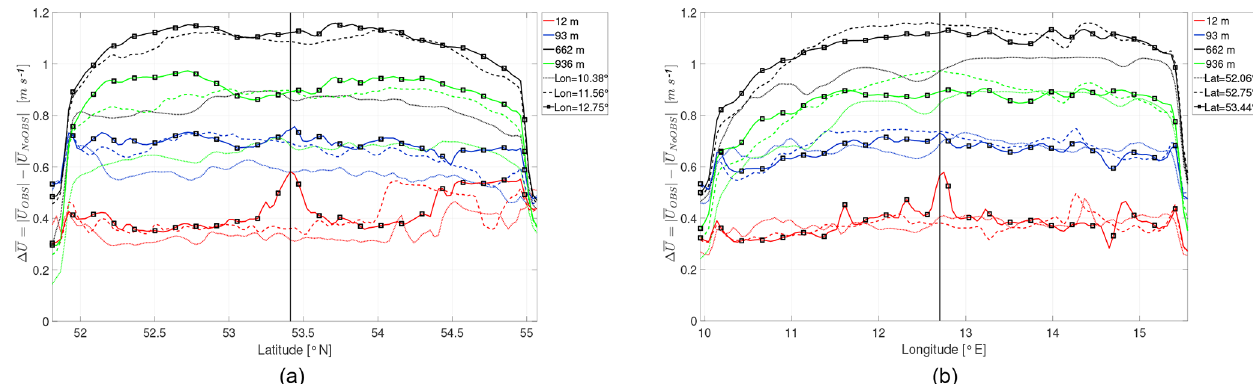
Figure 5. Mean absolute wind speed difference (cid:49)U along lines of constant longitude (a) and latitude (b) within the inner, nudged WRF domain. Approximate distance of d 3 ≈ 180km (dotted lines), d 2 ≈ 75km (dashed lines) and d 1 ≈ 0km (solid line) from the center (lat: 53 ◦ 10 (cid:48) 47.00 (cid:48)(cid:48) N, lon: 12 ◦ 11 (cid:48) 20.98 (cid:48)(cid:48) E) where the OBS model was nudged. The vertical line highlights the grid cell closest to the